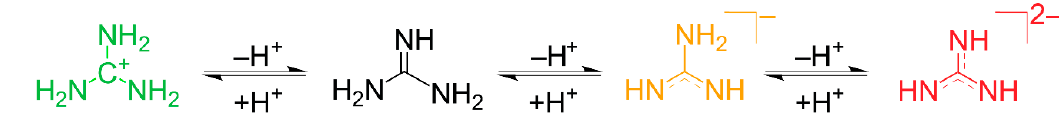
Figure 1. Protonation and deprotonation of guanidine from guanidinium on the left to the doubly deprotonated guanidinate on the right.